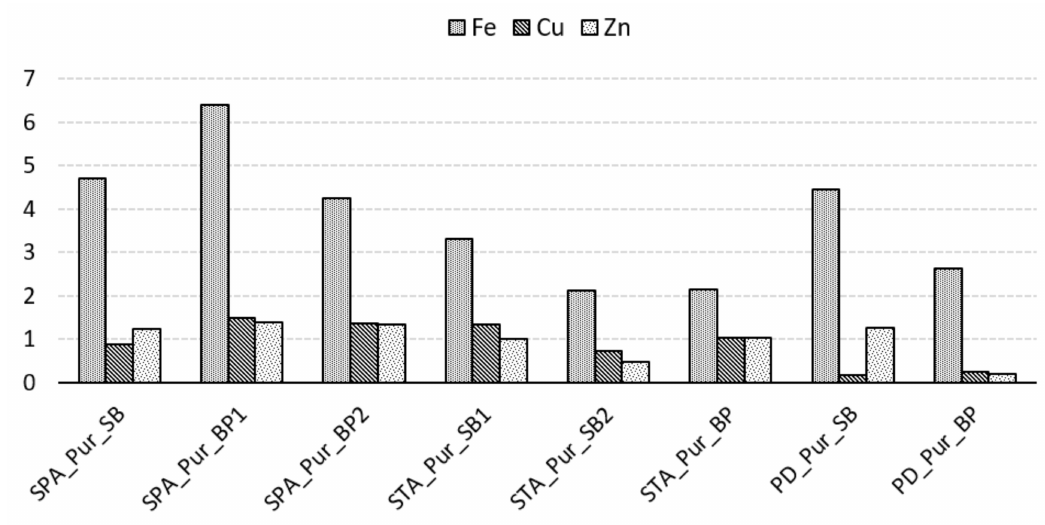
Figure 4. Estimates of Fe, Cu, and Zn detected by XRF analysis, corresponding to the purflings of the soundboard (SB) and back plate (BP) of the “Spagnoletti” (SPA), the “Stauffer” (STA), and the “Principe Doria” (PD). The y-axis values correspond to the net area counts of the element peaks (K α ) normalized to time and net area counts of the Rh peak (K α